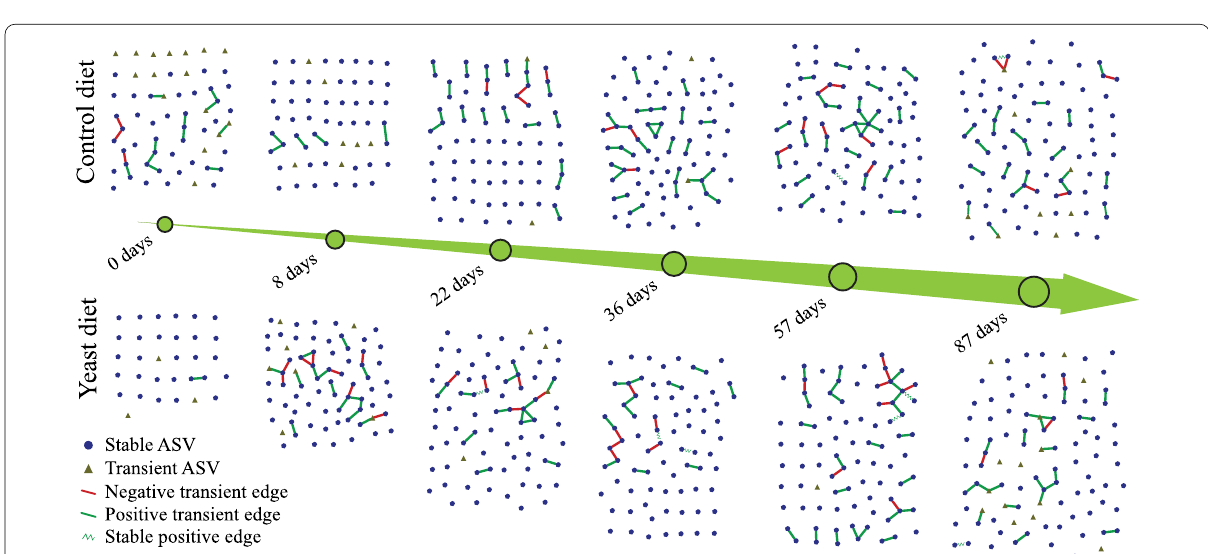
Fig. 5 Development of faecal microbial networks across time and feeding groups. Stable ASVs are defined as those nodes which were present in at least two consecutive networks. Transient ASVs are defined as those nodes which were not present in consecutive networks. Negative transient edges are defined as the edges that are present in one network, but do not appear in the following network. The “negative” means the presence of an inverse proportional relationship between two nodes (ASVs). Positive transient edges are defined as the edges that are present in one network, but do not appear in the following network. The “positive” means the presence of a proportional relationship between two nodes (ASVs). Stable positive edges are defined as the edges that are present in one network and in the following network. The “positive” means the presence of a proportional relationship between two nodes